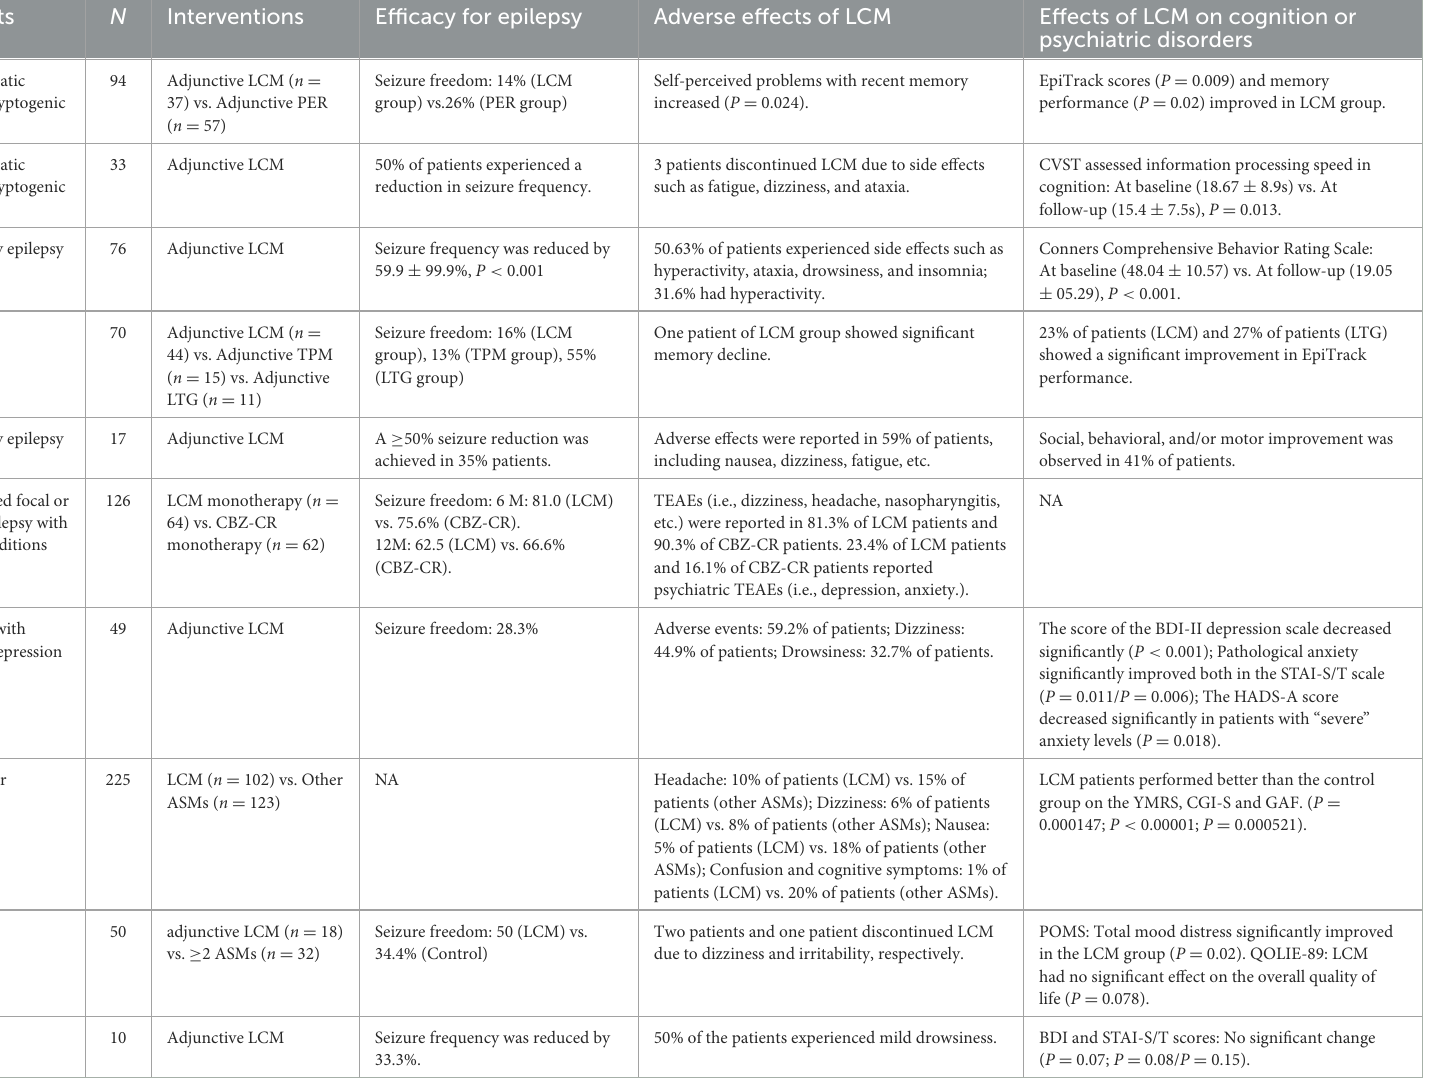
TABLE 1 Summaries of clinical trials on the effects of lacosamide treatment in epilepsy and psychiatric disorders. Authors